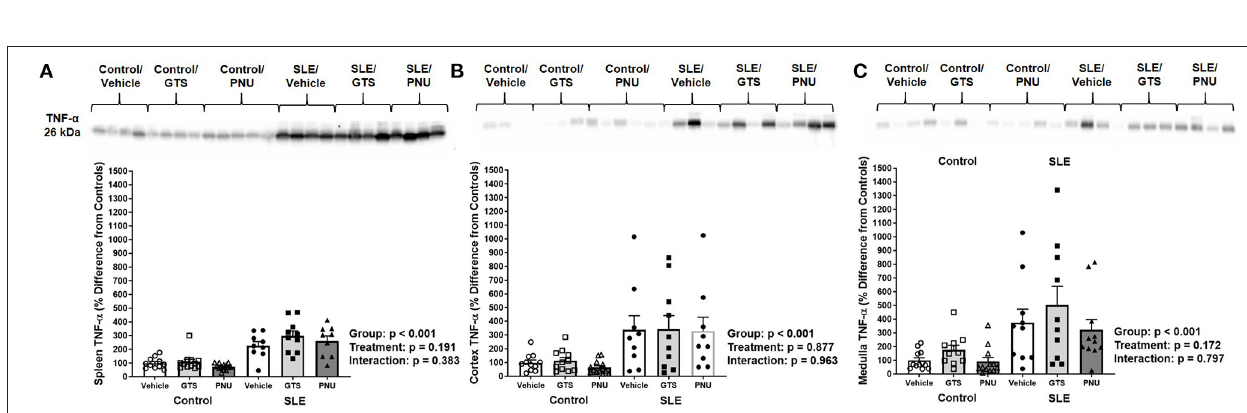
FIGURE 2 | Splenic (A) , renal cortical (B) , and medullary (C) TNF- α (presented as percent difference from controls) in control and SLE mice treated with either vehicle, GTS-21, or PNU-120596. Neither GTS-21 nor PNU-120596 had a significant effect on renal or splenic inflammation in control or SLE mice ( n = 9–13 per group). Data were analyzed using a two-way ANOVA and the results of this analysis are listed on the graph. Representative blots are included above each figure. The molecular weight of TNF- α is 26